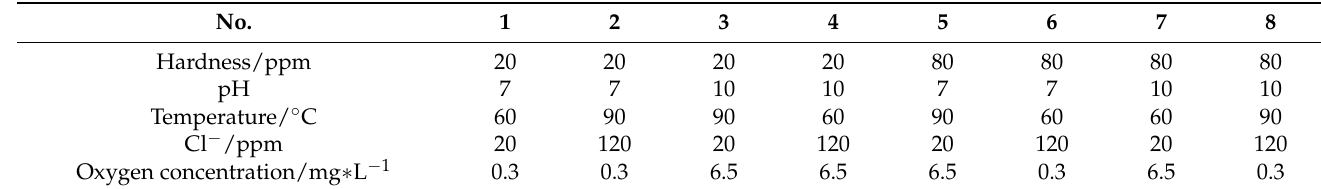
Table 1. Characteristic parameters of the simulated